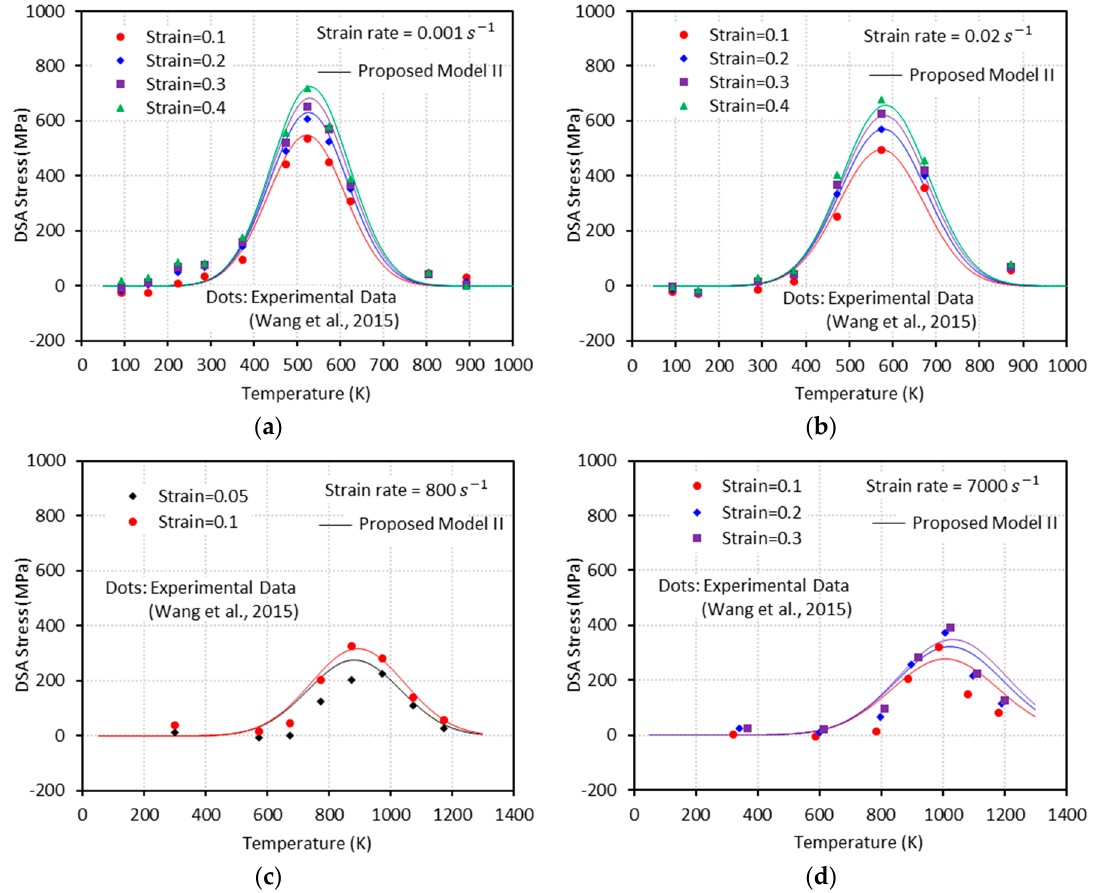
Figure 13. The DSA-induced flow stress versus temperature curves from the experiments [1] and the proposed model II with ( a ) (cid:2013)(cid:4662) = 0.001 (cid:1871) (cid:2879)(cid:2869) , ( b ) (cid:2013)(cid:4662) = 0.02 (cid:1871) (cid:2879)(cid:2869) , ( c ) (cid:2013)(cid:4662) = 800 (cid:1871) (cid:2879)(cid:2869) , and ( d ) (cid:2013)(cid:4662) = 7000 (cid:1871) (cid:2879)(cid:2869) . proposed model II with ( a ) . ε = 0.001 s − 1 , ( b ) . ε = 0.02 s − 1 , ( c ) . ε = 800 s − 1 , and ( d ) . ε = 7000 s − 1